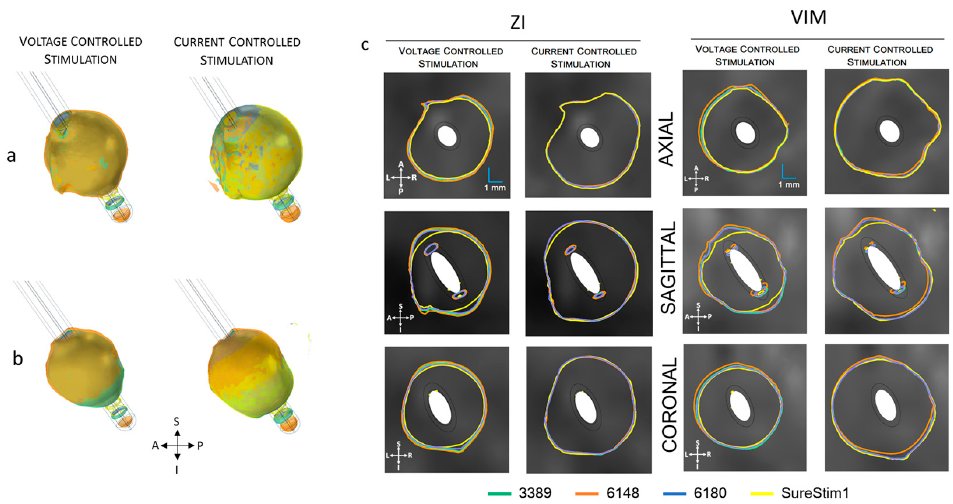
Figure 9. Electric field (EF) 0.2 V/mm isosurfaces achieved by each lead superimposed for each EF distribution of each lead operated in voltage (3 V) and current (3.4 mA). ( a ) EF isosurfaces at ZI in voltage (left) and current (right); ( b ) isosurfaces at VIM for voltage (left) and current (right); ( c ) Isocontours (0.2 V/mm) at the axial, sagittal and coronal planes. The cut planes for visualization were placed at the coordinates of the middle point of the active contacts. A: anterior, P: posterior, S: superior, I: inferior, L: left, R: right. Table 3. Maximum spatial extension (mm) of the 0.2 V/mm electric field isolevel achieved at each plane for voltage (3 V) and current (3.4 mA) controlled stimulation for all leads. Measurements performed at the ZI.